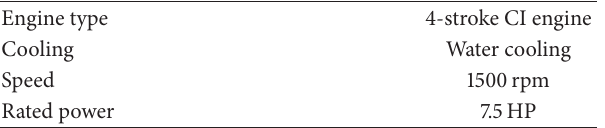
Figure 7: Graphical representation of amount of oil received with different time. Table 4: Engine specifications.